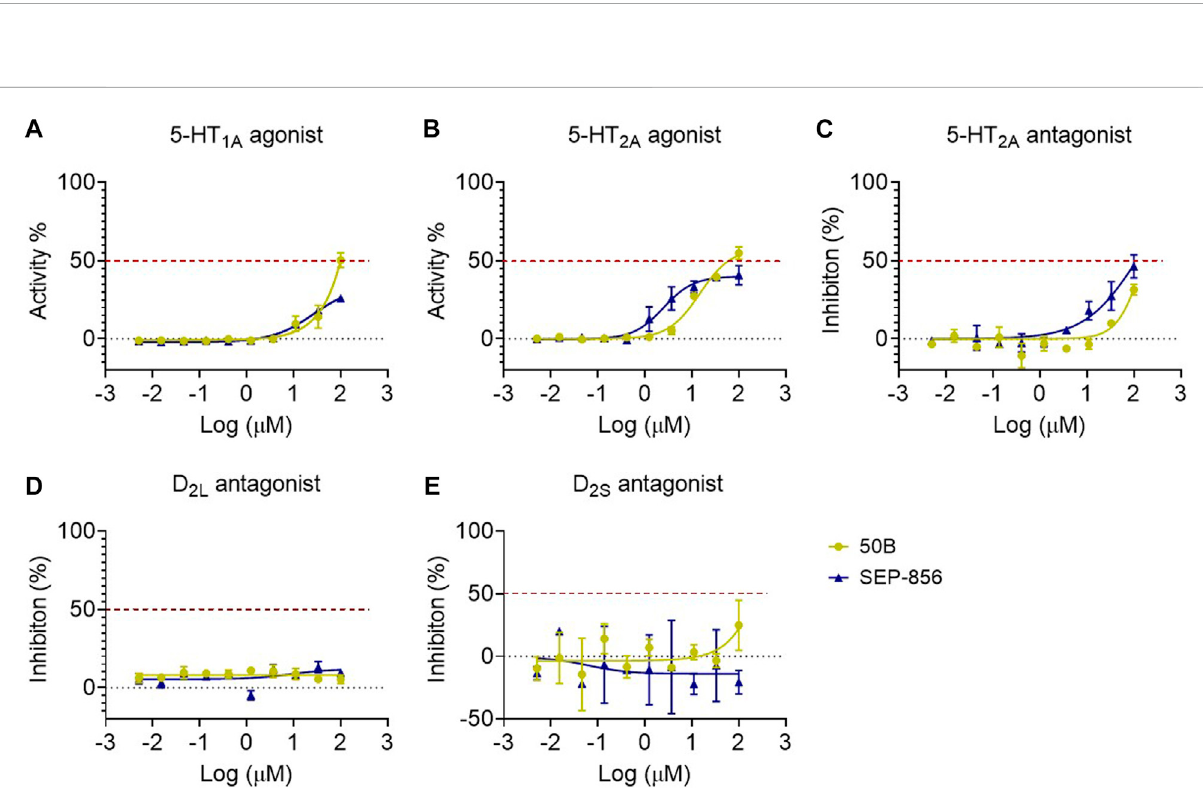
FIGURE 3 Agonist – antagonist activity of SEP-856 and 50B at 5-HT 1A , 5-HT 2A , dopamine D 2L , and D 2S receptors. (A) The 5-HT 1A receptor functional effect assay was determined using recombinant G α 15-CHO-Clone cells expressing human 5-HT 1A receptor, and the agonist effect was determined using the FLIPR Calcium Assay Kit. (B, C) The agonist or antagonist activity of 5-HT 2A receptors of the compounds was performed using Flp-In ™ -CHO Cell Lines expressing human 5-HT 2A receptors. The functional effect was also assessed via the FLIPR Calcium Assay Kit. (D, E) The dopamine D 2L and D 2S receptors ’ functionaleffectassaysweredeterminedusingrecombinantFlp-In ™ -CHOcellsexpressinghumandopamineD 2L receptors.Accumulationof cAMP was determined using the DiscoverX HitHunter cAMP XS + assay. Every assay was repeated three